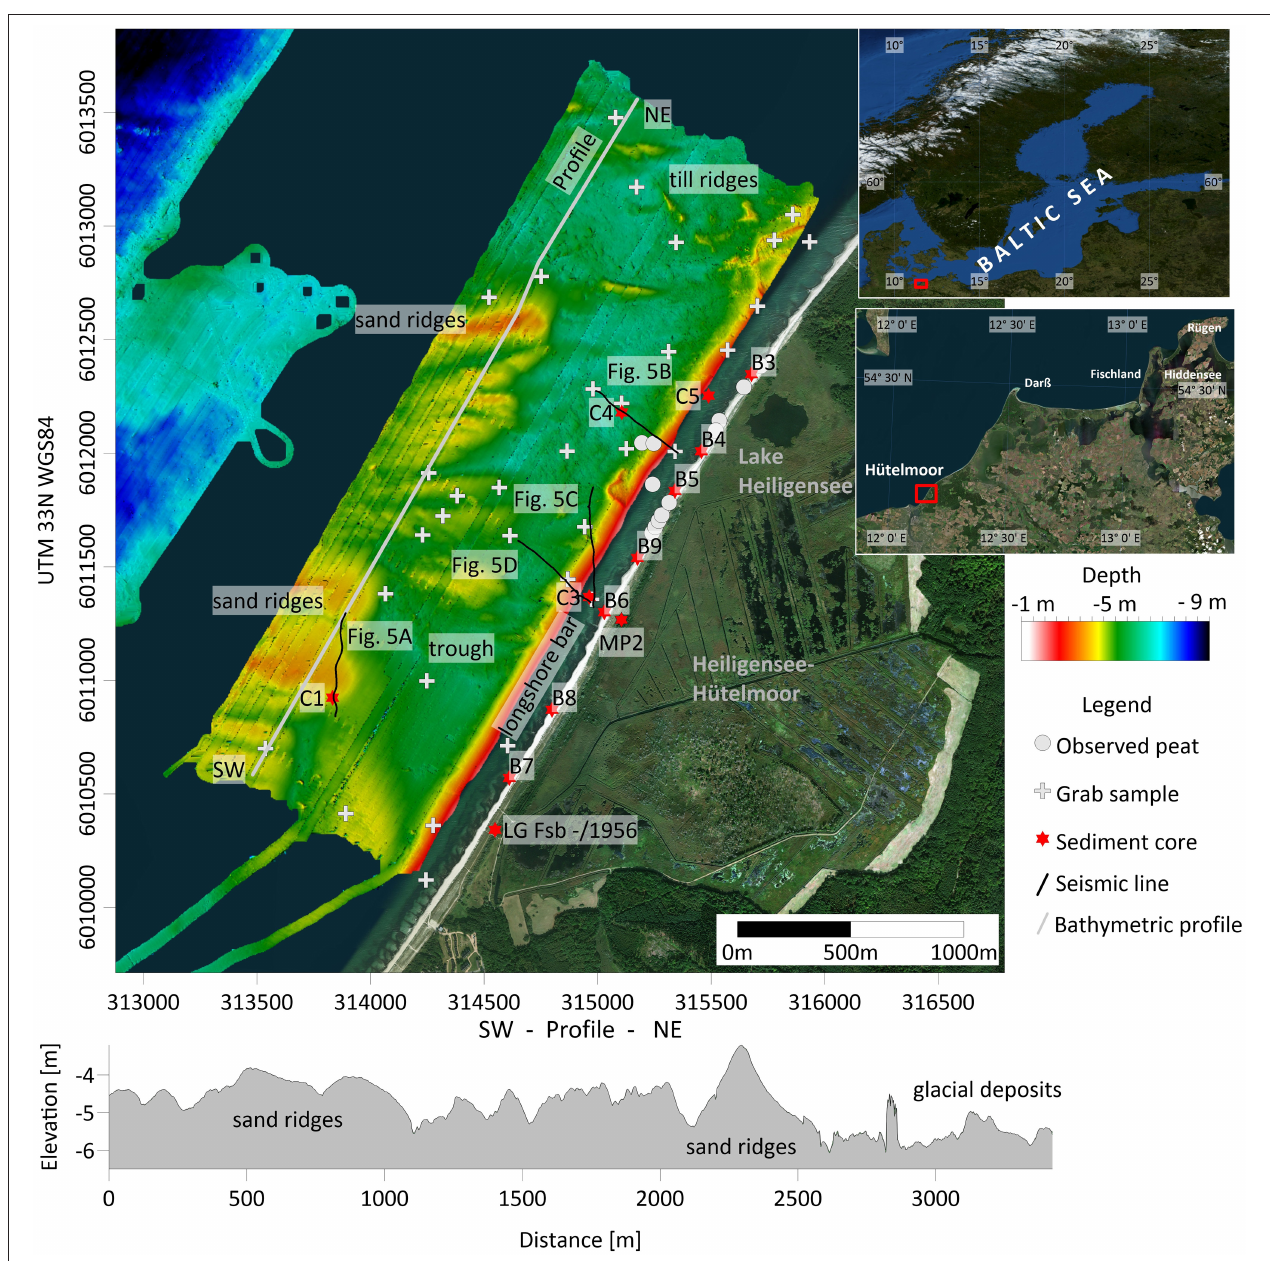
FIGURE 1 | (Top) Bathymetry and location of the study area along the southwestern Baltic Sea coast. White line parallel to the shore in SW-NE direction indicates the bathymetric cross section shown underneath. The positions of sediment cores (red stars) and grab samples (white crosses) are also indicated. The black lines show the locations of the seismic profiles. The longshore bar was identified from the parametric echosounder data (INNOMAR, see Methods). (Bottom) Bathymetric SW-NE transect at the upper shoreface indicating the distribution of the main geological